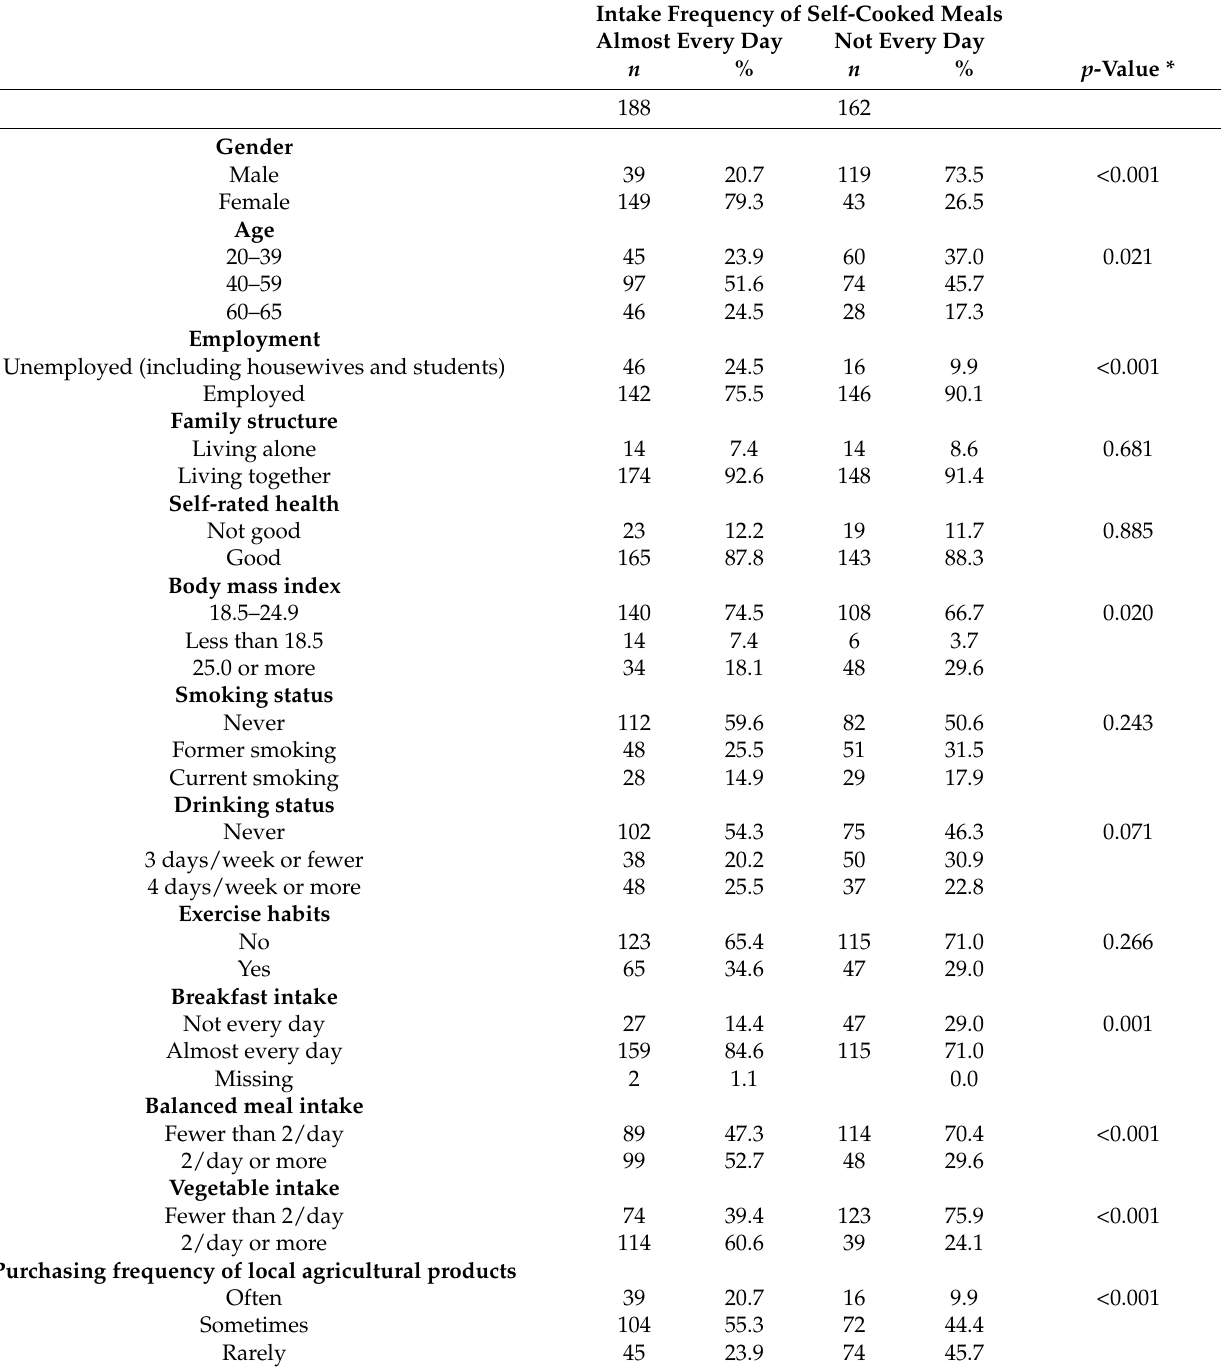
Table 2. Distribution of responses according to the intake frequency of self-cooked meals ( n =